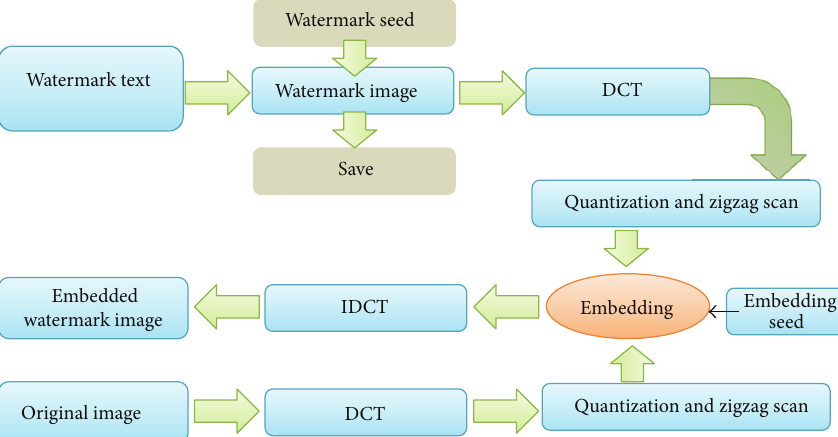
Figure 3: Insertion process of watermark.